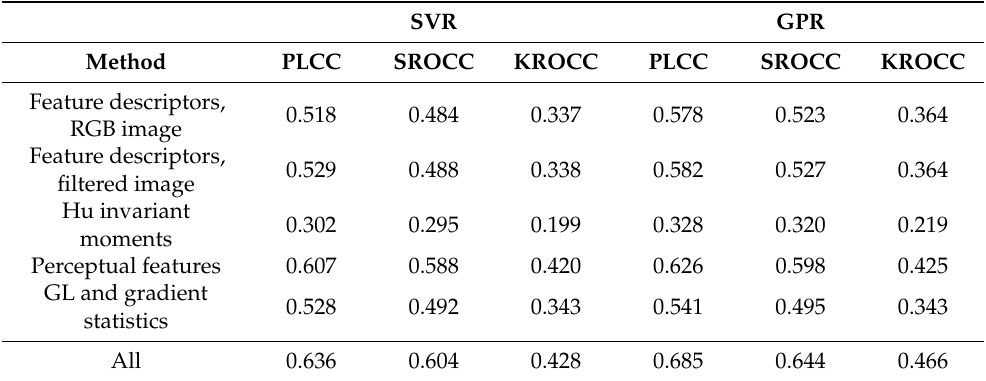
Table 6. Ablation study on CLIVE [45] database. Median PLCC, SROCC, and KROCC values were measured over 100 random train–test